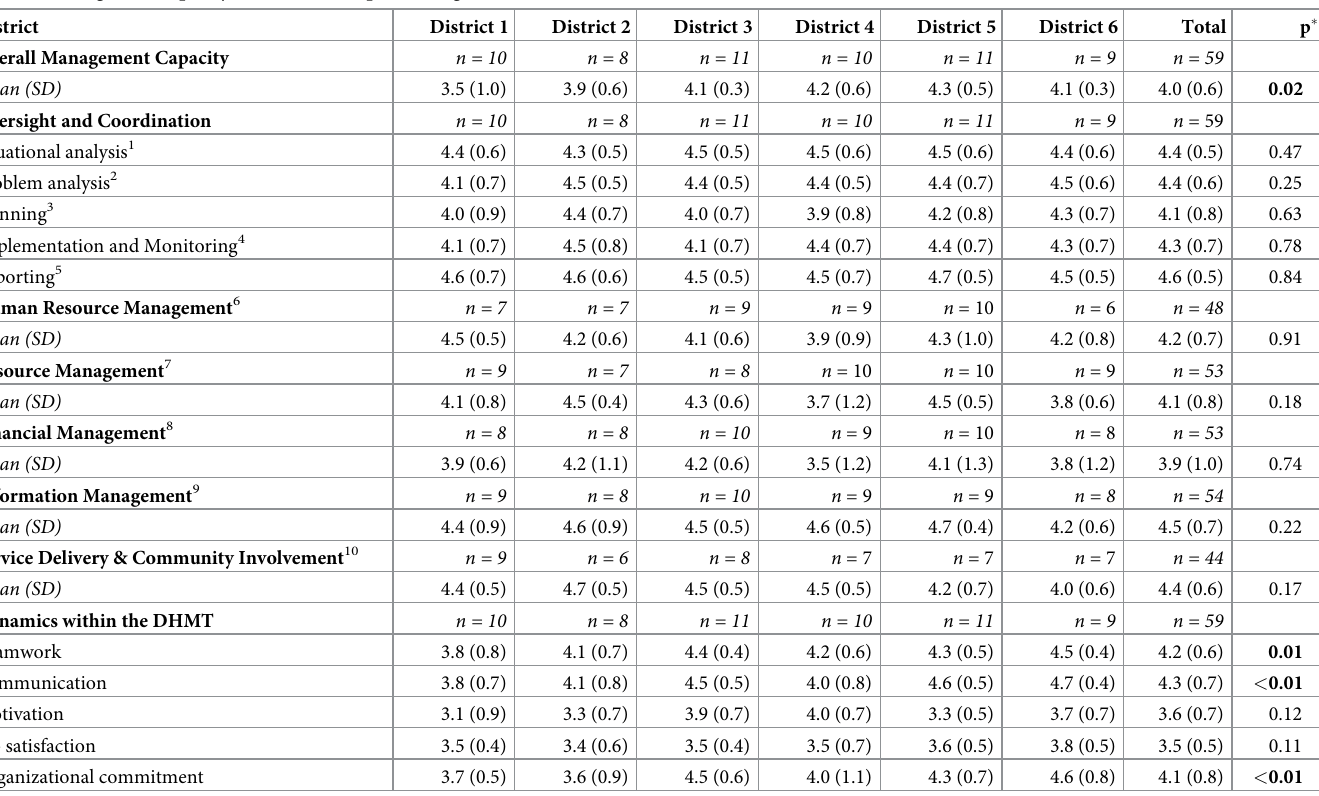
Table 5. Management capacity across different performing